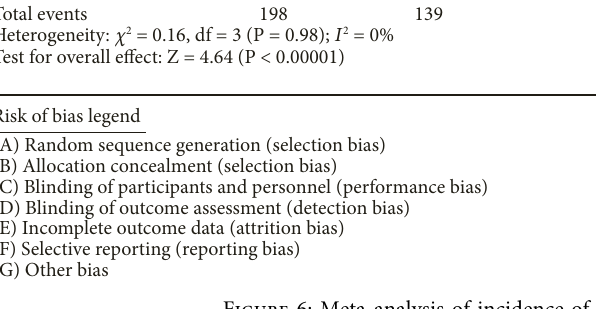
Figure 6: Meta-analysis of incidence of wound infection between two groups.